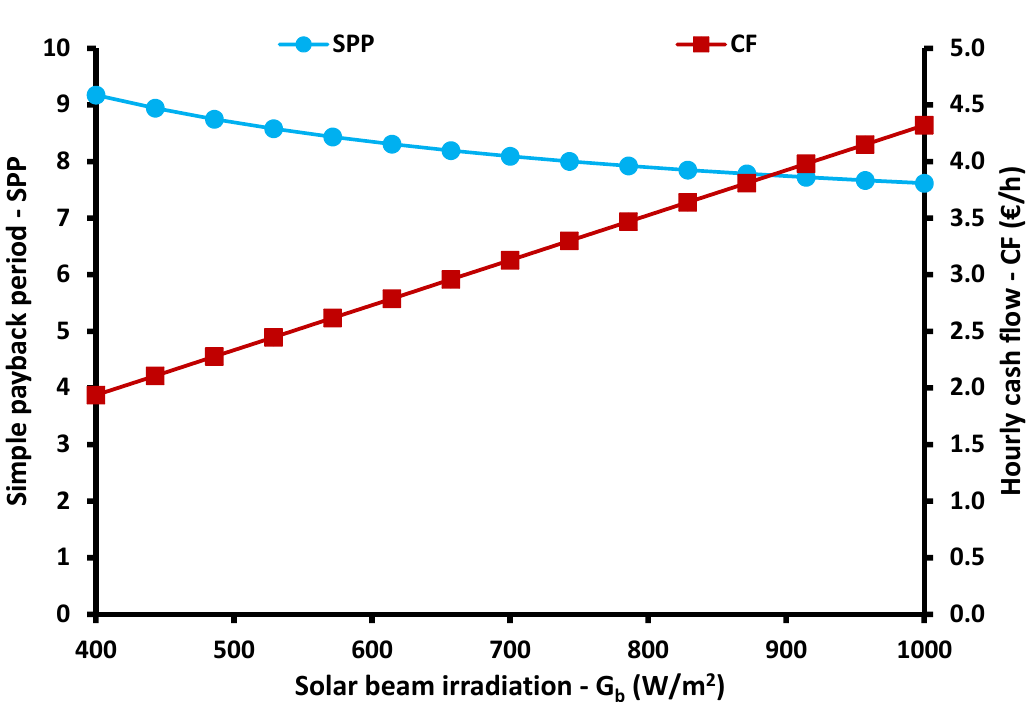
Figure 18. Energy and exergy efficiency for different solar irradiation levels.